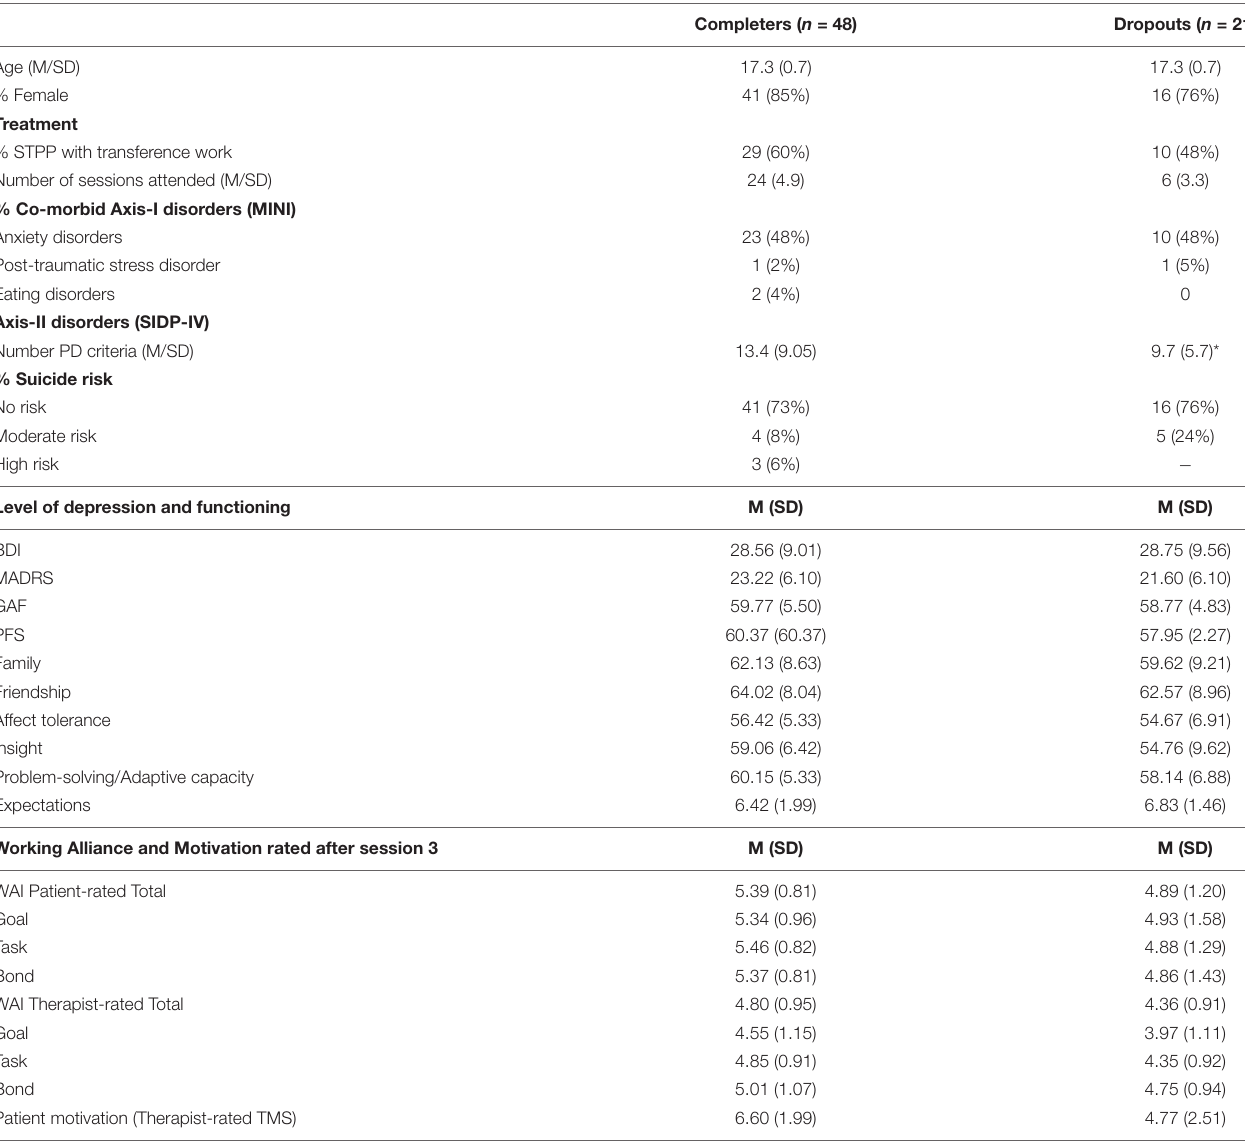
TABLE 1 | Pre-treatment characteristics, working alliance, number of sessions, and randomisation group for treatment completers and